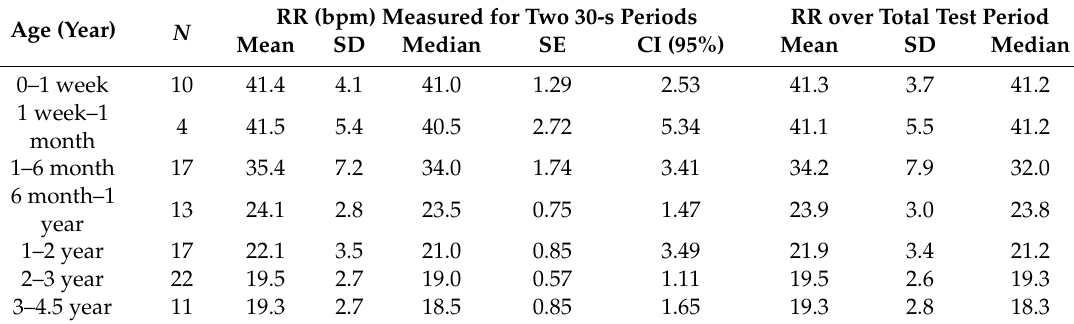
Table 4. Respiratory rate (RR) in healthy subjects during quiet sleep calculated by two methods. Age